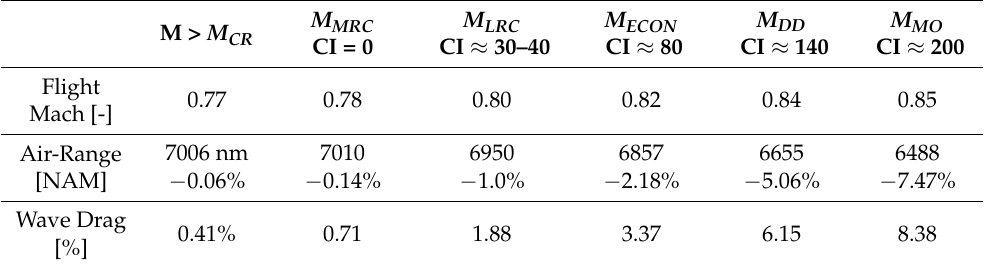
Table 7. Flight Mach, maximum still-air range, and wave-drag percentage of the total drag for various flight conditions at constant in-flight weight of 350,000 lb flying at 35,000 ft ISA. M MRC M LRC M ECON M DD M MO M > M CR CI = 0 Flight 0.77 Mach [-] 7006